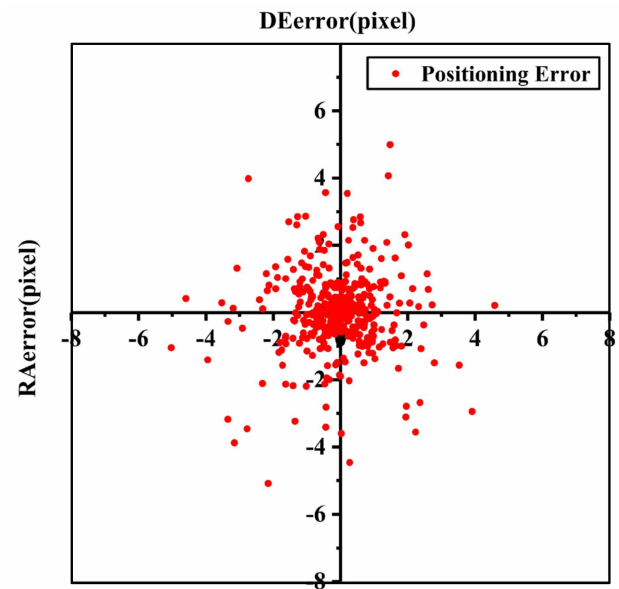
Figure 6. Distribution of the positioning error.